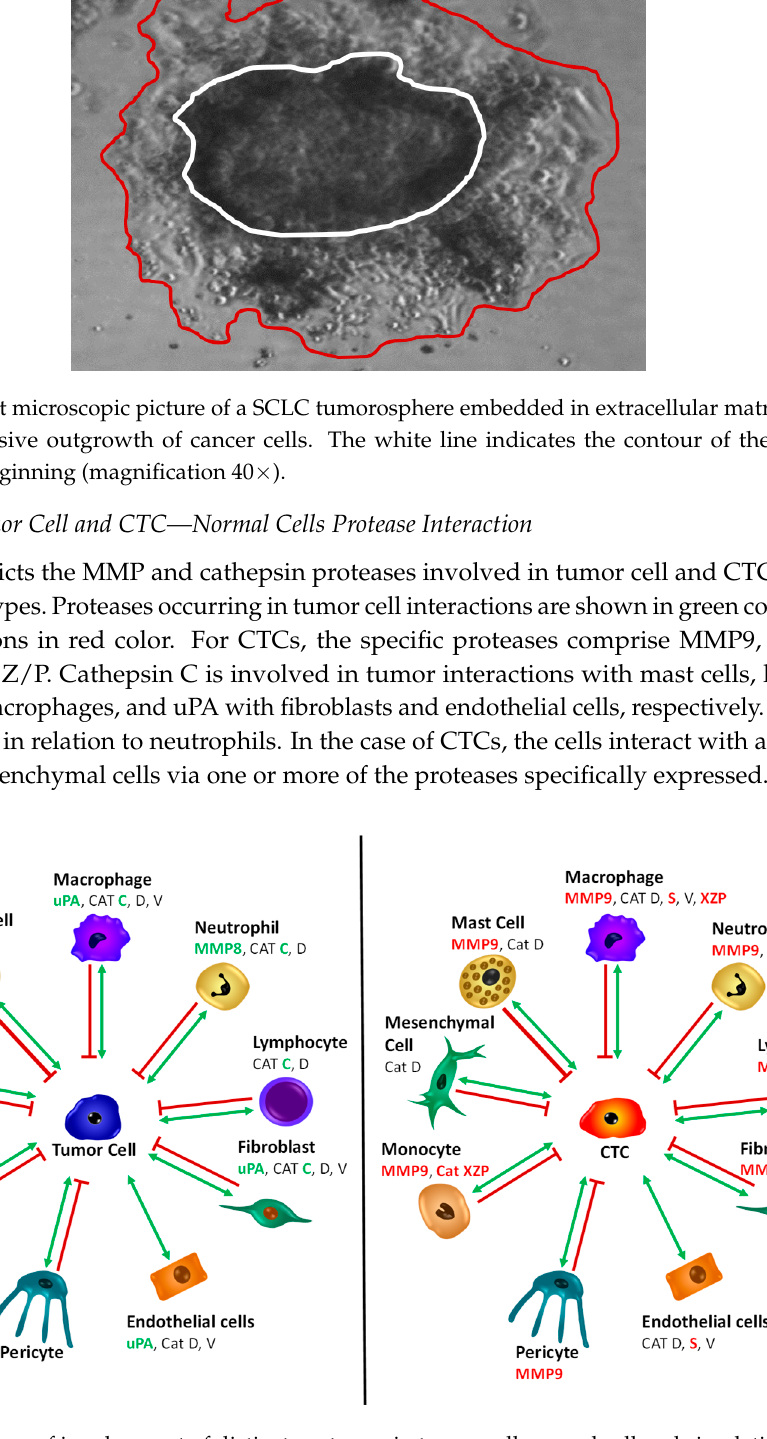
Figure 6. Scheme of involvement of distinct proteases in tumor cell ‐ normal cell and circulating tumor cells ( CTC) ‐ normal cell interactions.